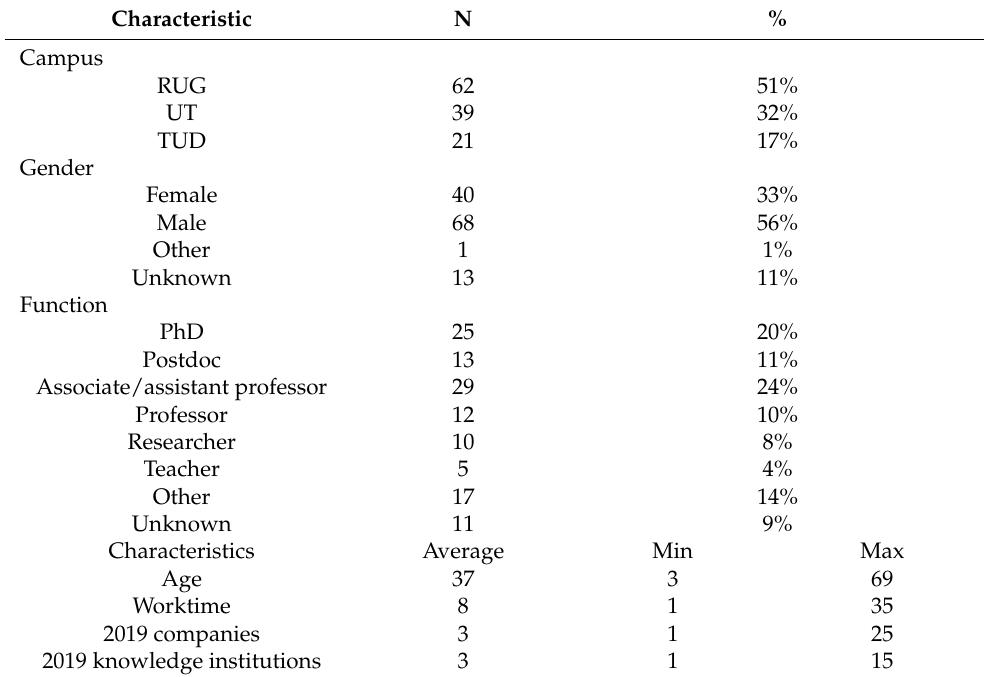
Table A2. Respondent characteristics for knowledge institution